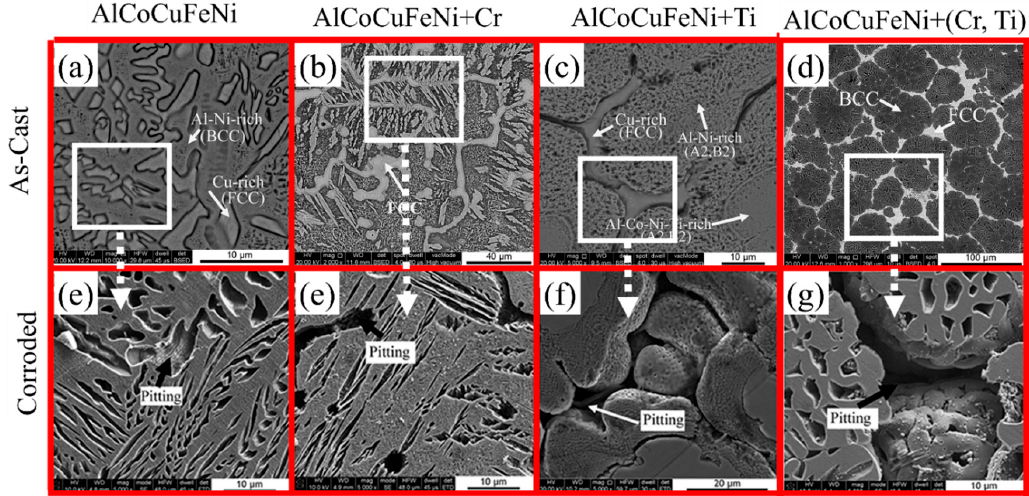
Figure 11. As-cast ( a – d ) and corroded ( e – g ) microstructures of AlCoCuFeNi-Cr/Ti alloys. Inter-dendritic phases containing Cu were observed to corrode and dissolve rapidly. In the case of alloys containing both Cu and Ti, the lighter FCC phase dissolved leaving behind rounded dendrite features [40] (reprinted with permission from Elsevier).